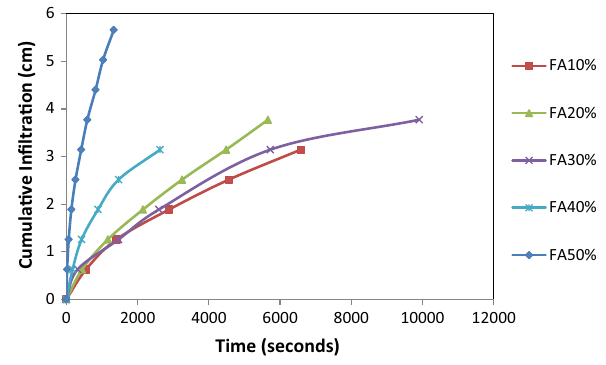
Fig. 5 Cumulative infiltration versus time for varying fly ash at 10% moisture content